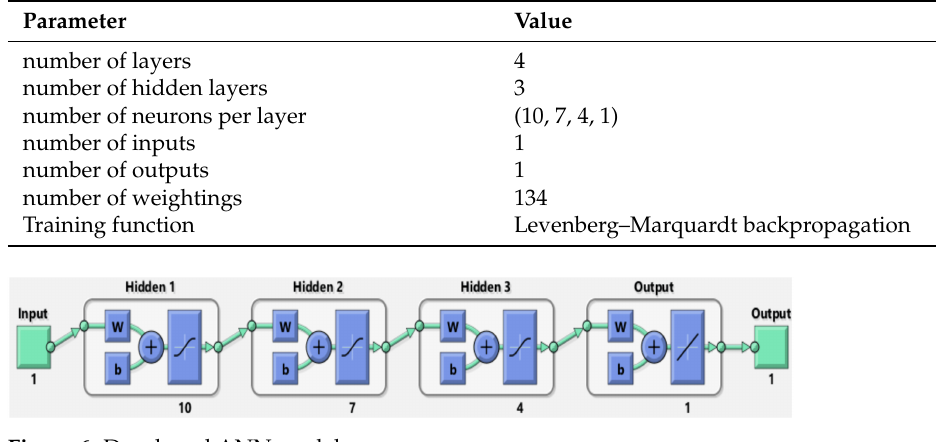
Figure 6. Developed ANN model.